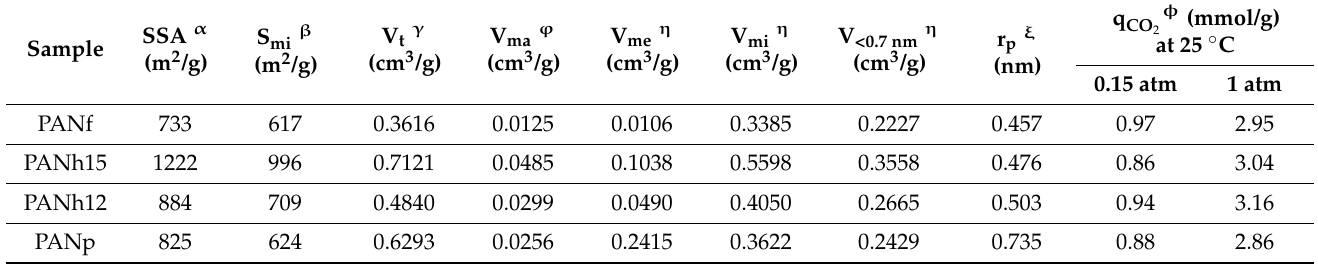
Table 1. Surface feature of the samples determined from N 2 adsorption–desorption